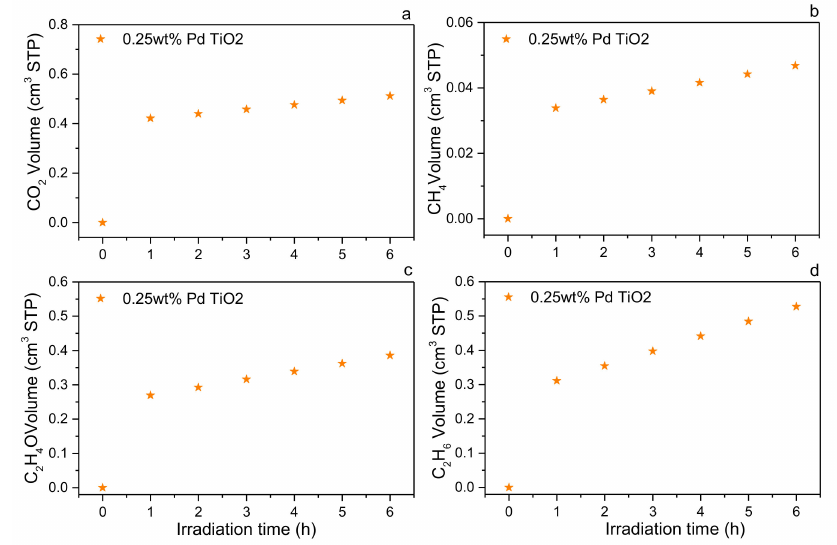
Figure 10. Hydrocarbon Profiles of ( a ) Carbon dioxide (CO 2 ), ( b ) Methane (CH 4 ), ( c ) Acetaldehyde (C 2 H 4 O) and ( d ) Ethane (C 2 H 6 ) at 0.25 wt% Pd. Conditions: Photocatalyst concentration 0.15 g / L, 2.0 v / v % ethanol, argon atmosphere, pH = 4 ± 0.05 after UV light photoreduction.